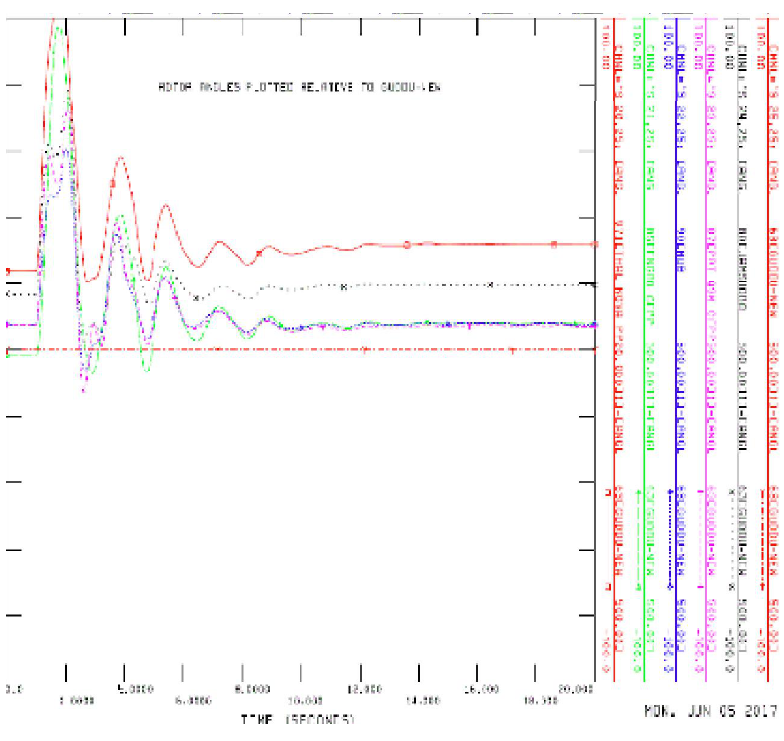
FIG. 13(d). RECOVERY OF ROTOR ANGLES RELATIVE TO GUDDU-NEW WITH